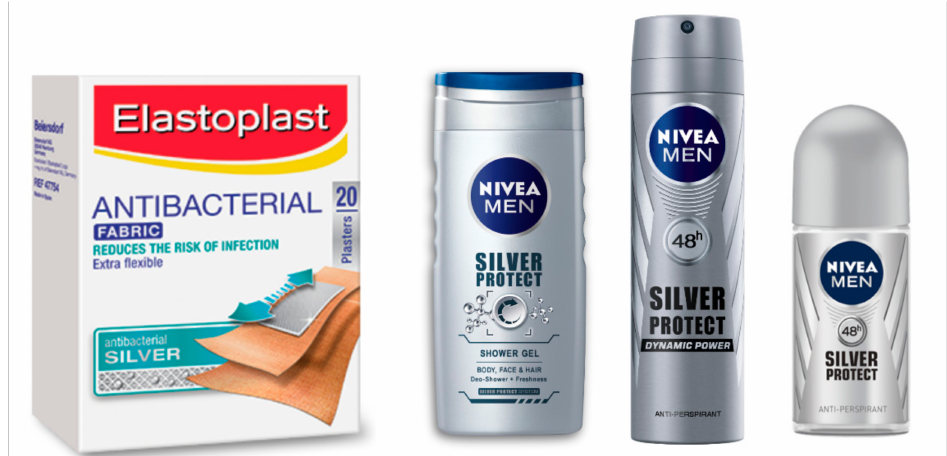
Figure 3. Commercial utilization of silver in consumer product lines, including Elastoplast (First aid bandages) and NIVEA (Shower gels and deodorants) for enhanced antimicrobial properties. Images used with permission of Beiersdorf AG,